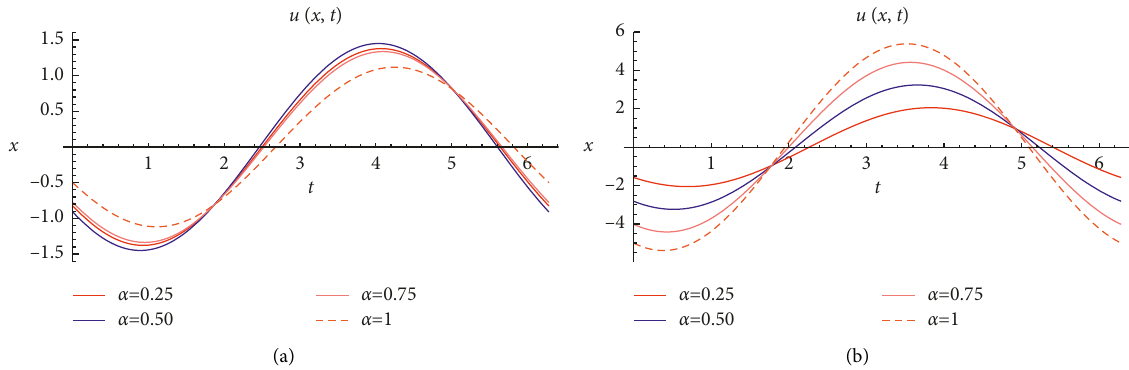
Figure 2: Plot of u ( x,t ) for real part and imaginary part for different values. (a) Real part of u ( x,t ) for equation (1) at t � 1. (b) Imaginary part of u ( x,t ) for equation (1) at t � 2.